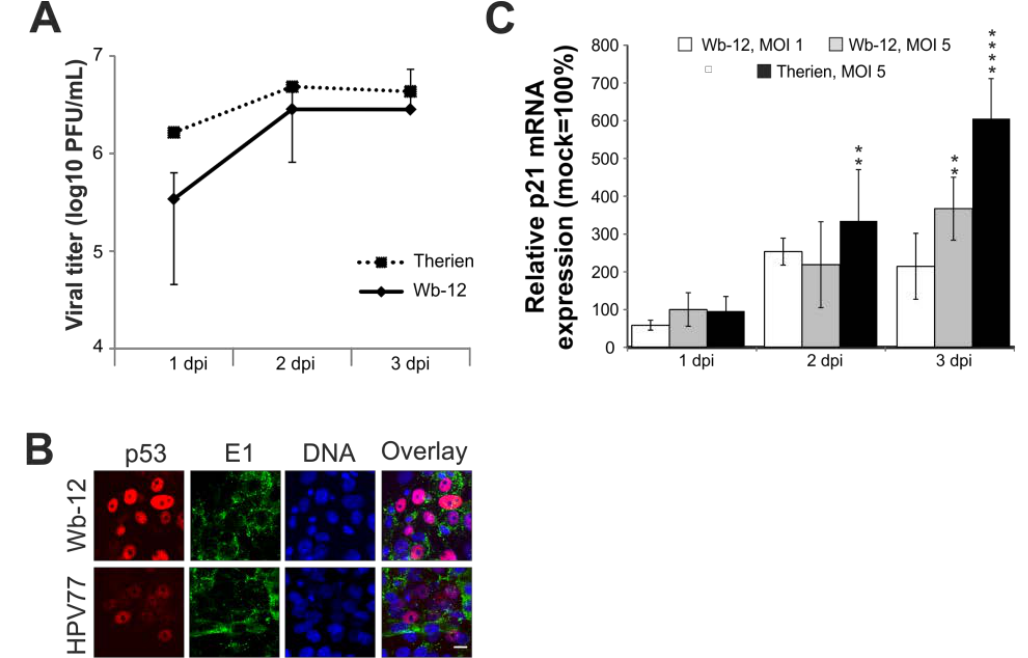
Figure 8. The course of infection of the clinical isolate RVi/Wuerzburg.DEU/47.11 (Wb-12) as compared to the cell culture-adapted strains Therien and HPV77. ( A ) Determination of Wb-12 viral titer over time of infection (1 to 3 dpi) by plaque assay in comparison to Therien; ( B ) Immunofluorescence analysis was performed with anti-p53 antibody to assess intracellular distribution of p53 (shown in red). RV infection was visualized with anti-E1 antibody (shown in green). Nuclear DNA is shown in blue. Pink colour indicates overlap areas. ( C ) Alteration of the mRNA expression level of p21 after infection with RV strains, Therien and Wb-12. The mRNA expression level was determined at 1, 2 and 3 dpi relative to the corresponding mock sample (set at 100%). Scale bar, 20 μm. * p < 0.05, ** p < 0.01, *** p < 0.001, **** p < 0.0001